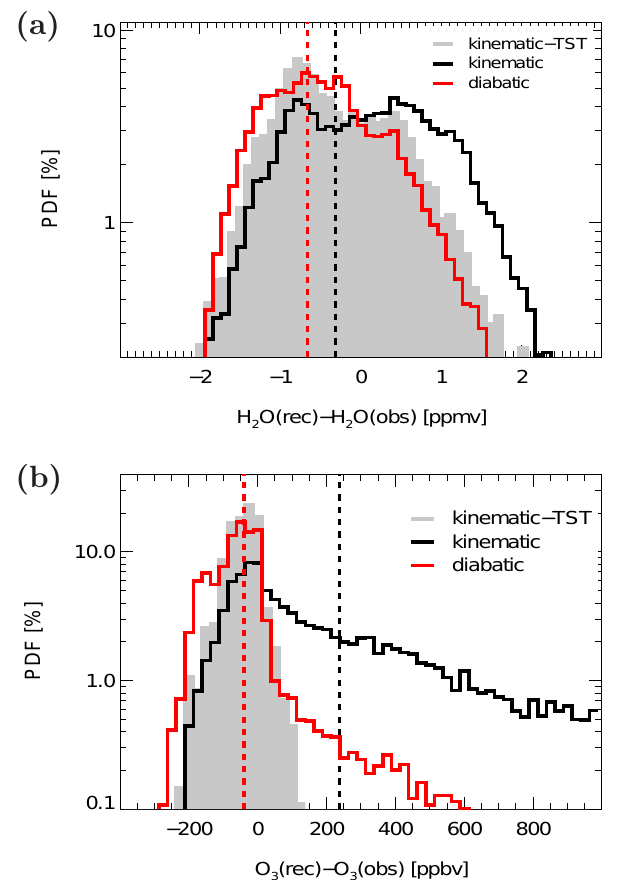
Fig. 4. Probability distribution functions (PDFs) of differences between observed and reconstructed water vapour (a) and ozone (b) between 390 and 420K. The bin size is 25ppbv (0.1ppmv) for ozone (water vapour). Dashed lines show the means of the distri- butions. The grey shading shows the PDF for the kinematic TST